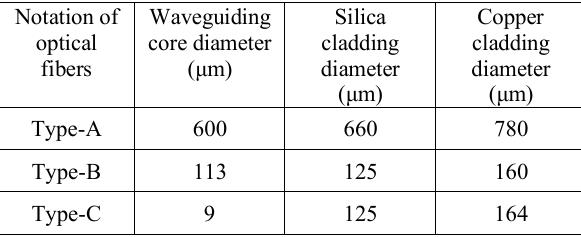
Table 1. The main parameters of the studied optical fibers with a copper